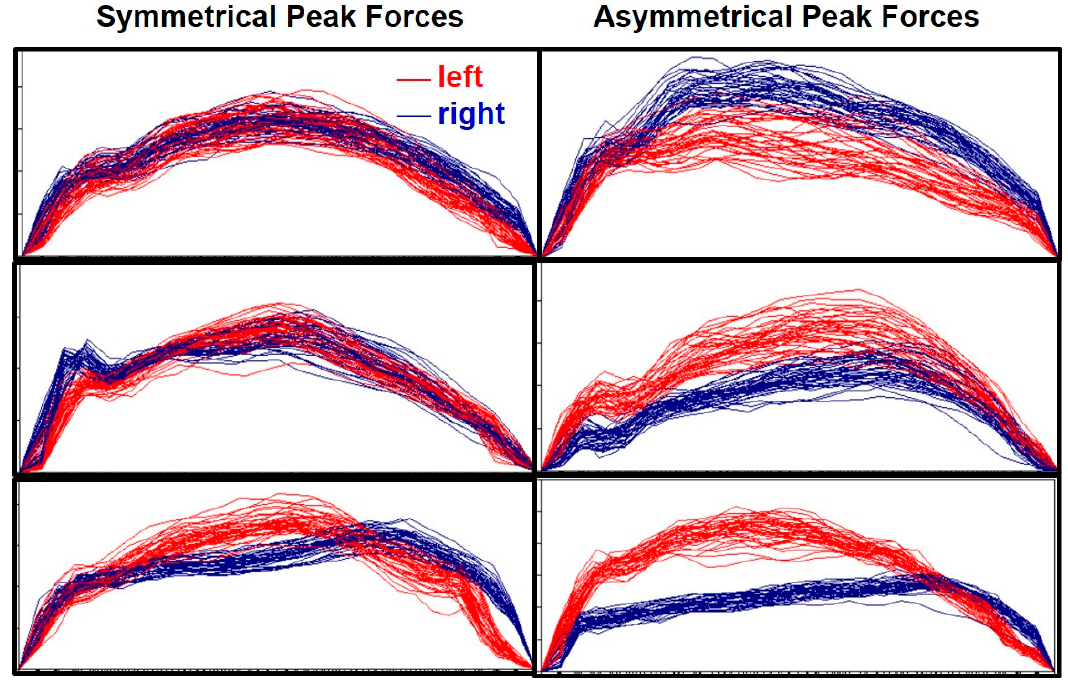
Figure 5. Examples of time-normalised stroke force profiles of the left (red) and right (blue) strokes. Each panel presents data of all analysed strokes within one participant during 200-m maximal effort paddling.